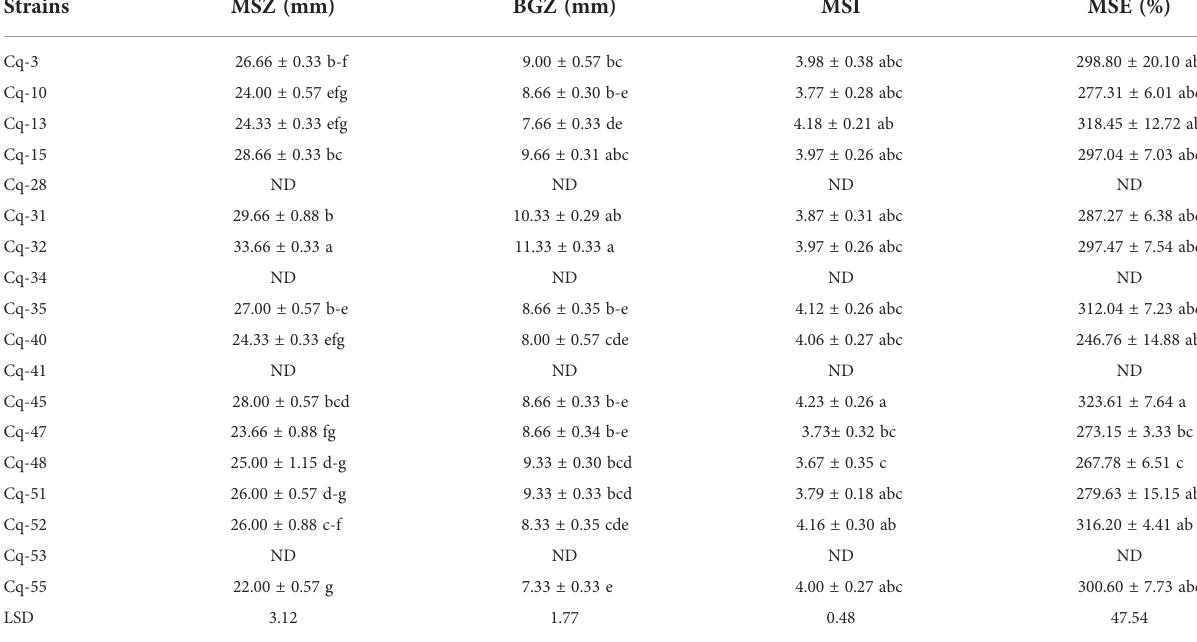
TABLE 3 Solubilization of manganese by phosphate solubilizing bacterial strains isolated from quinoa rhizosphere. Strains